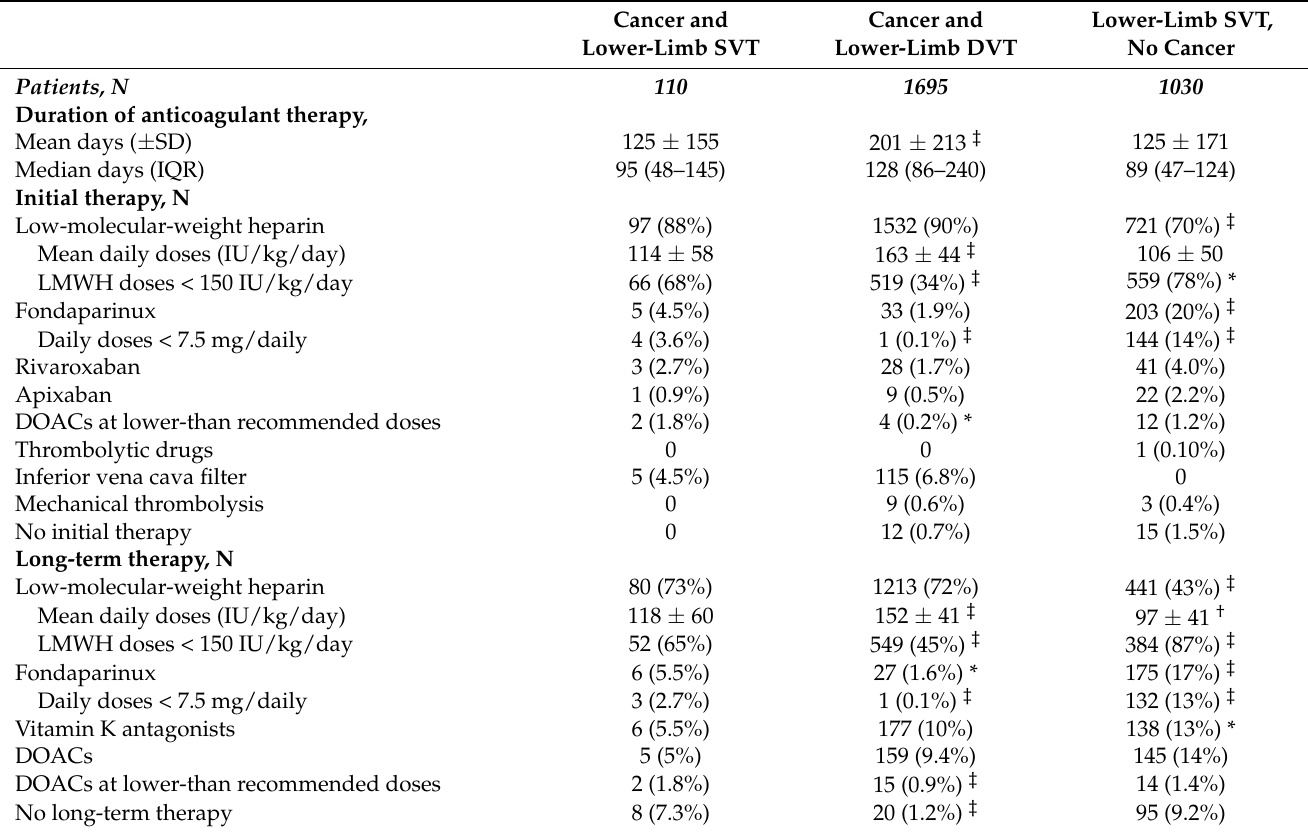
Table 3. Treatment